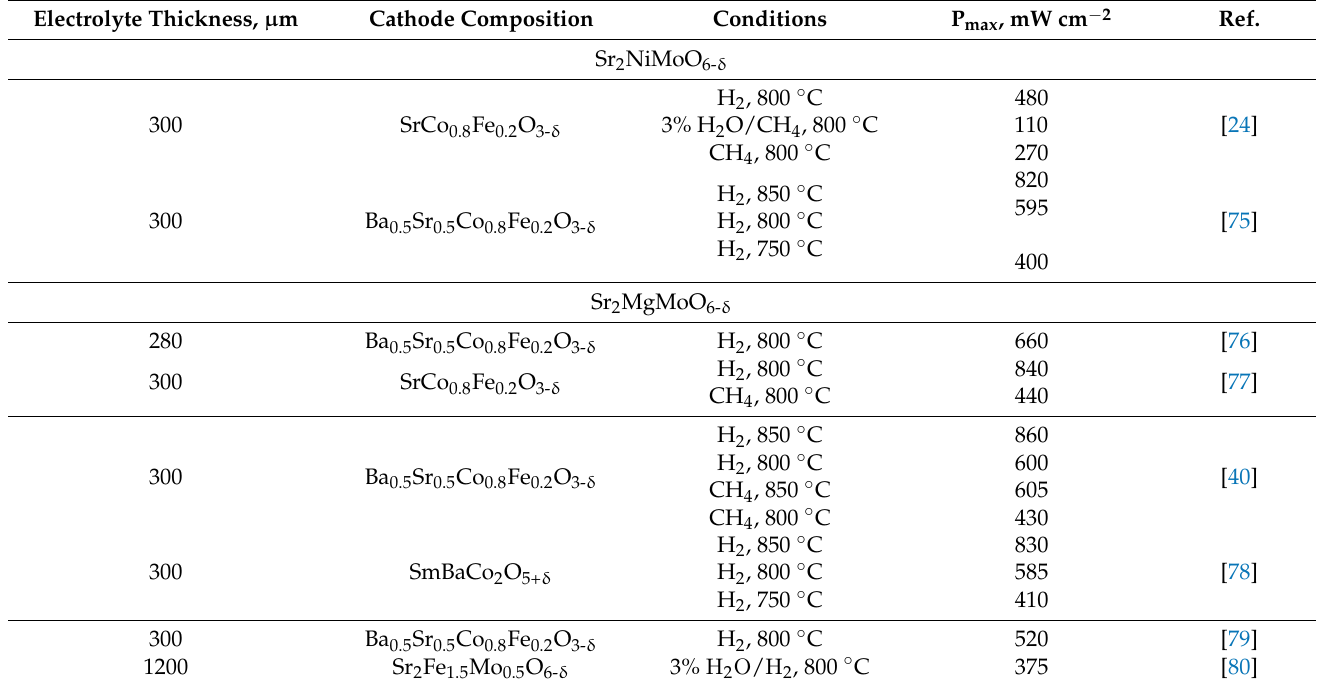
Table 1. Performance of SOFCs based on double Sr 2 MMoO 6- δ molybdates and La 1-x Sr x Ga 1–y Mg y O 3- δ (LSGM) electrolytes. Electrolyte Thickness, µ m Cathode